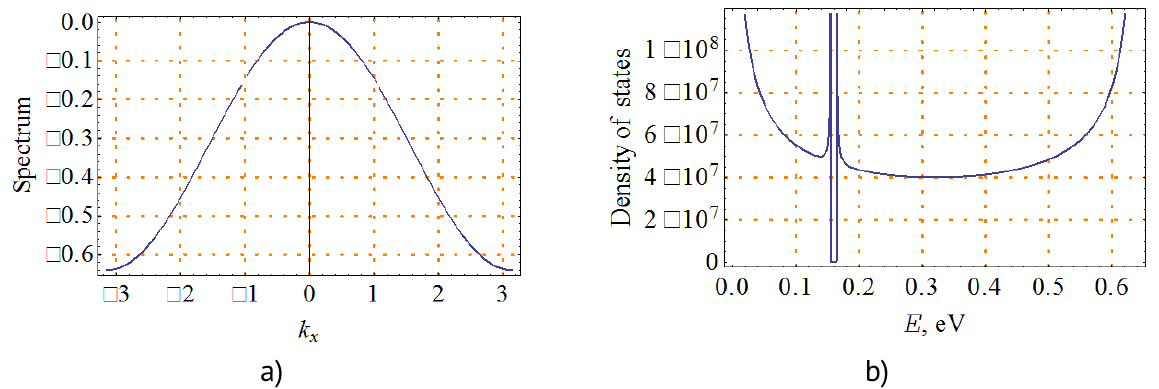
Figure 2. Energetic spectrum (a), and density of electronic states (b) for T = 200